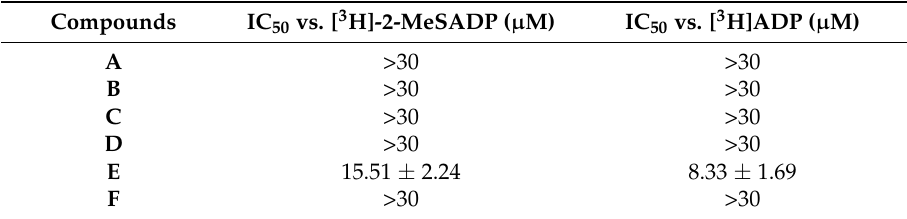
Table 2. Determination of IC 50 values of selected compounds. Table 2. Competitive binding affinities of selected compounds for rhP2Y12